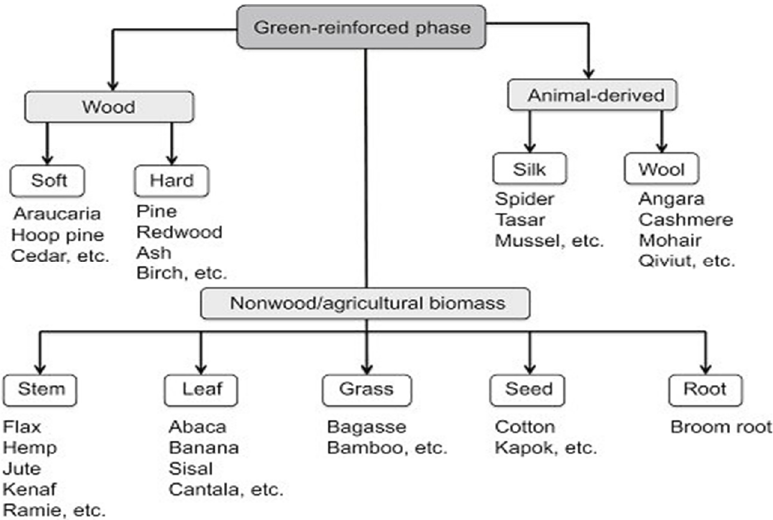
Figure 1. The natural reinforcement constituents of green composites. (Reproduced with a copyright permission from Nagalakshmaiah et al. [23]).